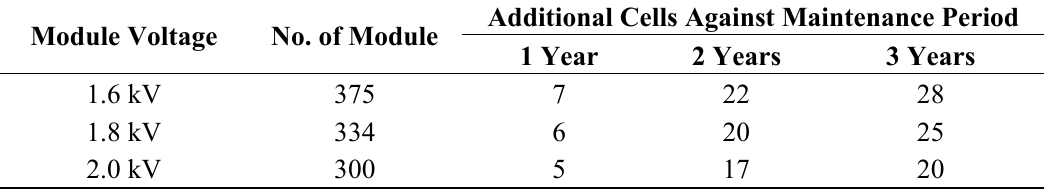
Table 3. Additional modules against maintenance period and module